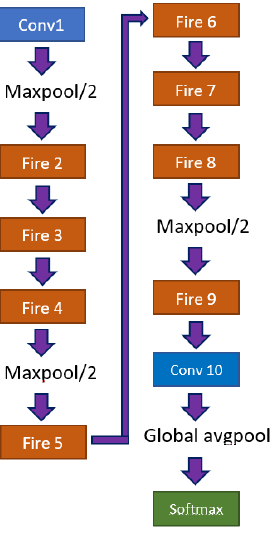
Figure 5. Architecture of a SqueezeNet